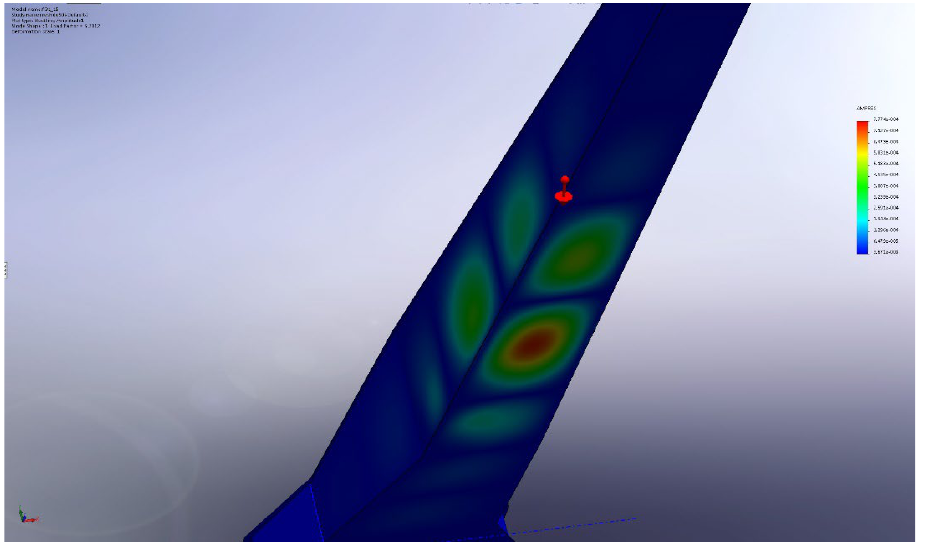
Figure 9. Buckling study.